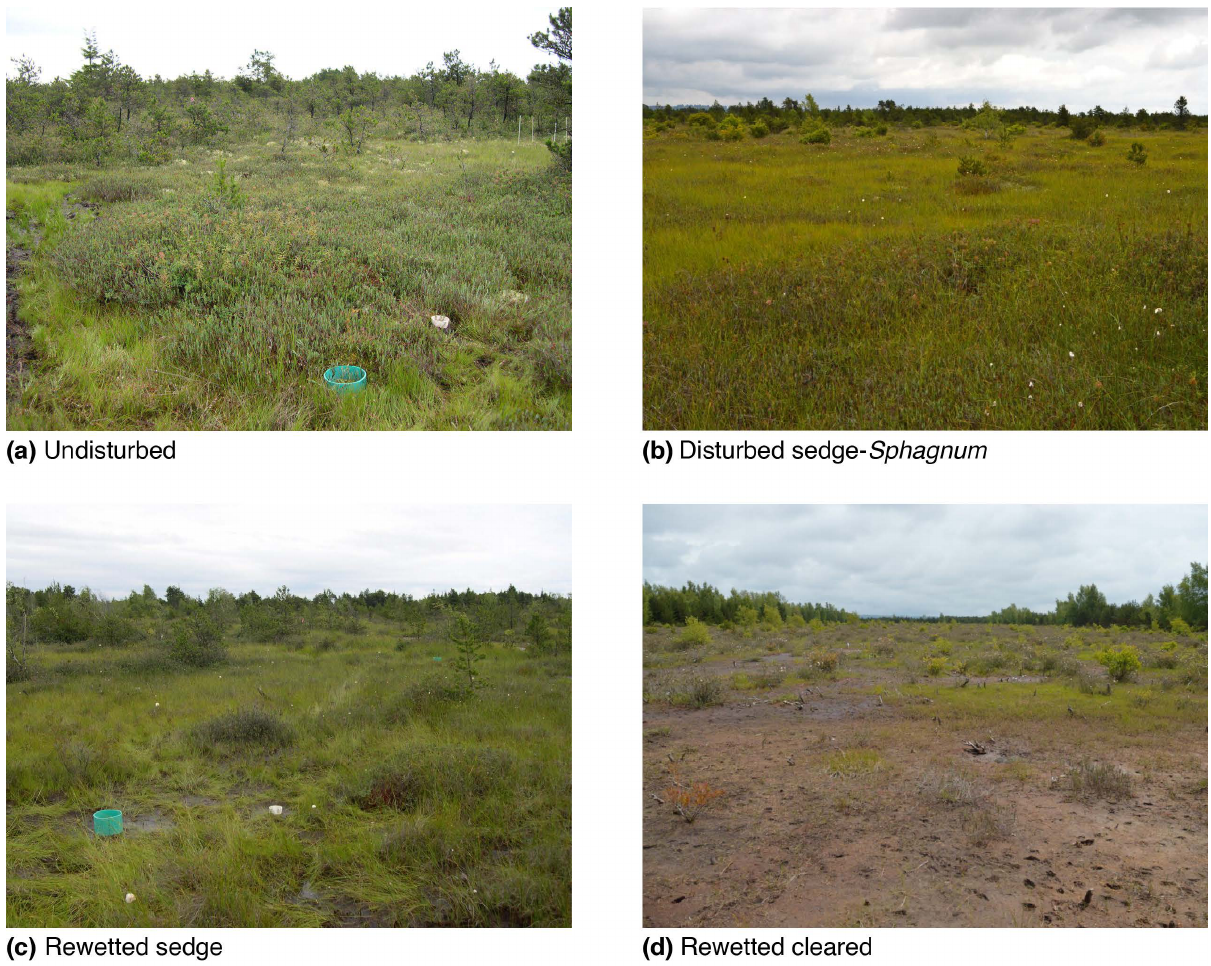
Figure 1. Photographs of the four chamber measurement sites in June